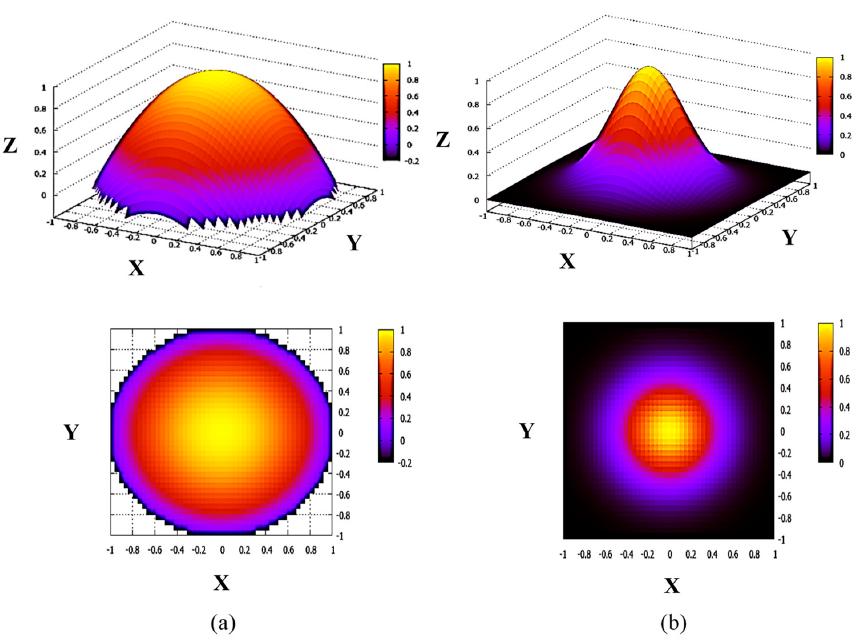
Figure 3. 3D and 2D images of circular primary beam with parabolic, y = 1 − x 2 ( a ) and bell-shape, y = exp( − 5 x 2 ) ( b ), current density profiles.